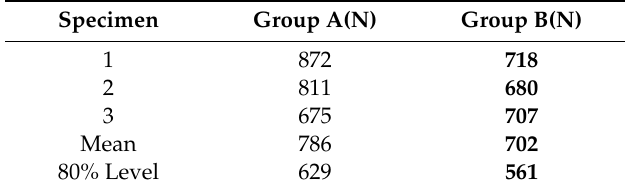
Table 1. Mean maximal load-bearing capacity (N) and 80% level for each experimental